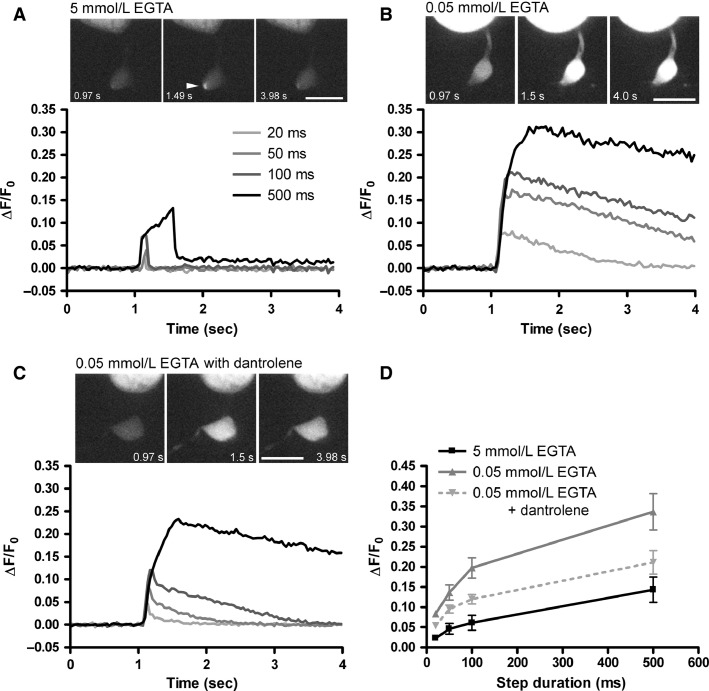
Endogenous levels of Ca2+ buffering promote CICR-mediated boosting of intraterminal Ca2+ signals in rods. (A) Fluorescent Ca2+ signals measured in the synaptic terminal of a rod dialyzed with 5 mmol/L EGTA and 500 μmol/L OGB-5N in response to depolarizing voltage steps (to –19 mV from a Vhold = –79 mV) of varying duration (20, 50, 100, and 500 msec). The peak ΔF/F0 amplitude increased with increasing step duration and the Ca2+ transients declined rapidly at the end of the voltage step. The top panel shows the OGB-5N fluorescence images in a single rod terminal before (0.97 sec), at the peak (1.49 sec), and after (3.98 sec) the 500 msec step. The fluorescence signal in this cell was constrained to a hotspot near the base of the terminal (arrowhead). Scale = 10 μm. (B) The amplitudes of Ca2+ signals were enhanced and the recovery slowed with 0.05 mmol/L intracellular EGTA. Top panel showing the OGB-5N fluorescence images demonstrates that with 0.05 mmol/L EGTA, the OGB-5N fluorescence was stronger, was spread throughout the terminal, and was still elevated at the end of the acquisition period (4.0 sec). Scale = 10 μm. (C) The enhancement with 0.05 mmol/L EGTA was inhibited by including 50 μmol/L dantrolene in the patch pipette of a different rod, consistent with a role for CICR in boosting intraterminal [Ca2+]. The top panel shows images of OGB-5N fluorescence within the rod terminal. Scale = 10 μm. (D) Group data showing the increase in ΔF/F0 with increasing step duration, the enhancement with 0.05 mmol/L EGTA, and the inhibition with dantrolene.